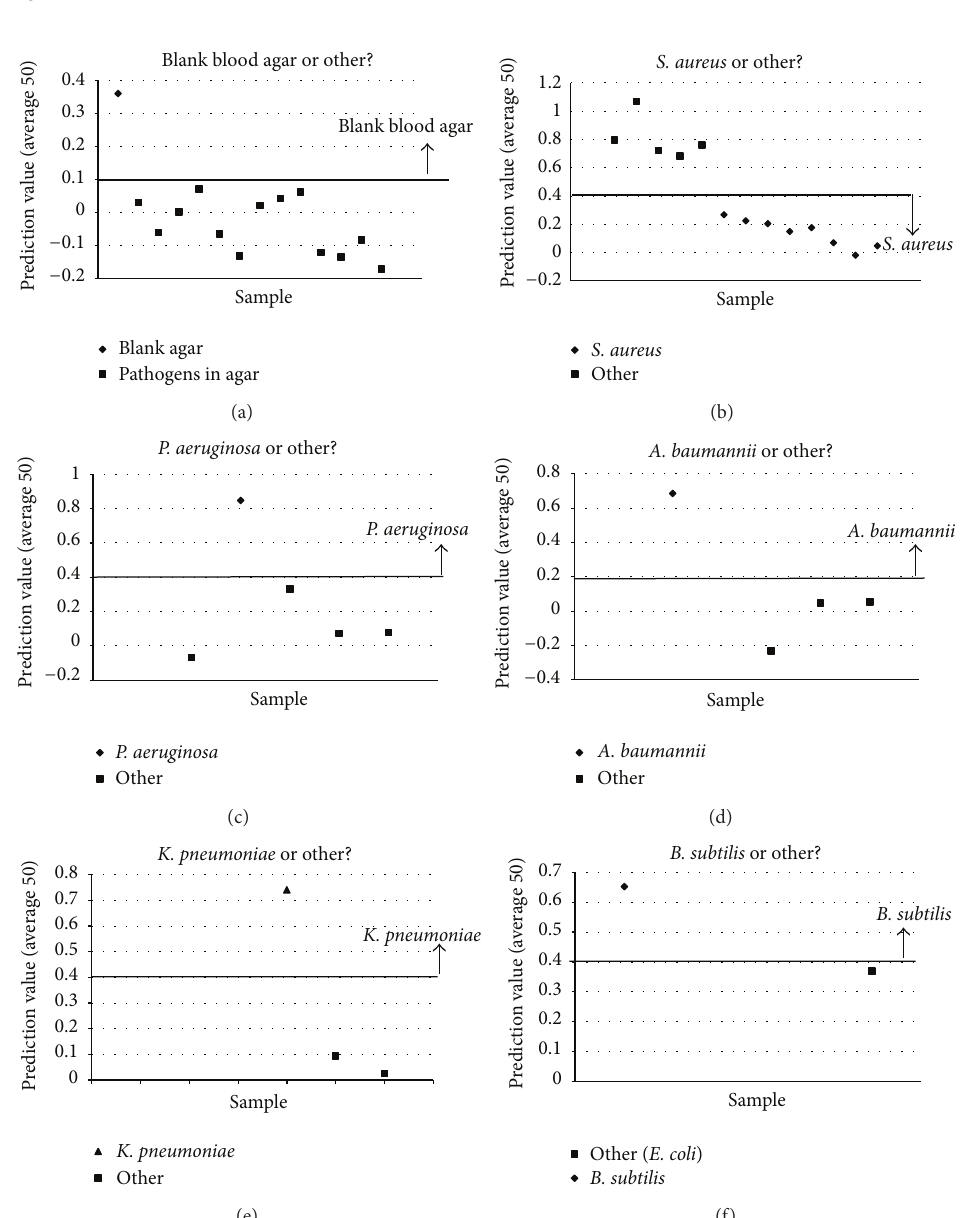
Figure 5: Plots of the prediction values obtained when discrimination models in the main branch of the discrimination algorithm were tested using the verification